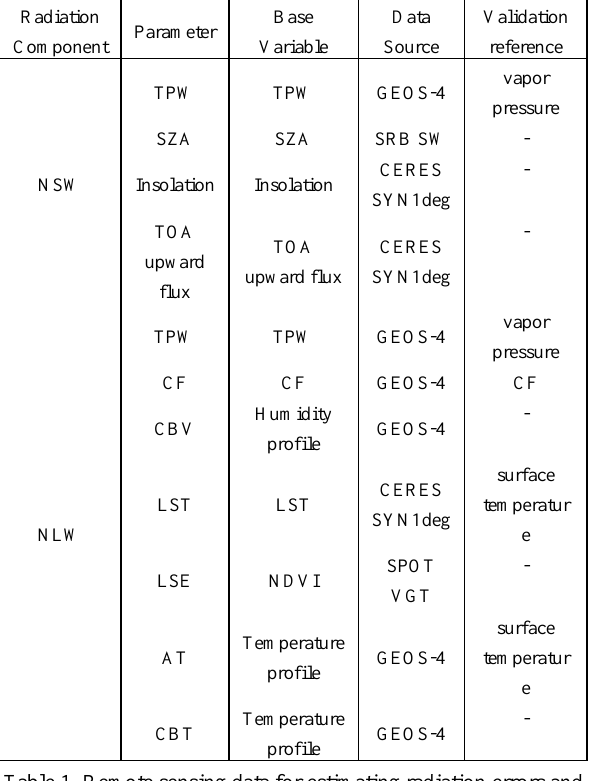
Table 1. Remote sensing data for estimating radiation errors